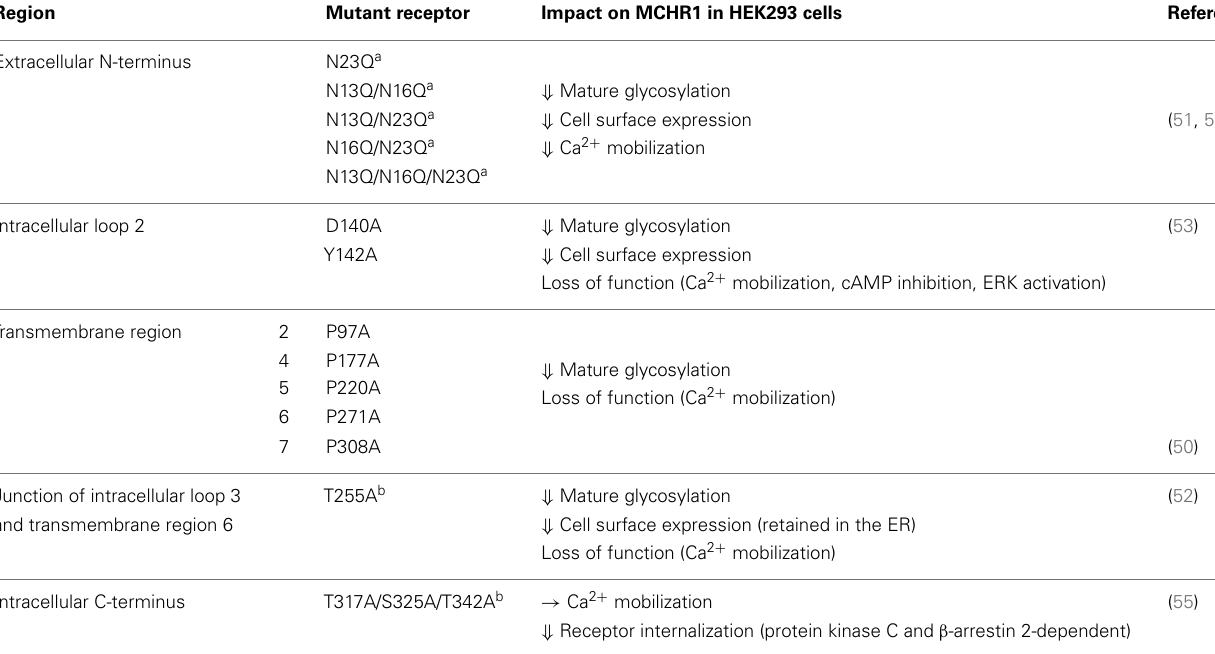
Table 1 | Posttranslational modifications with cellular function in mammal